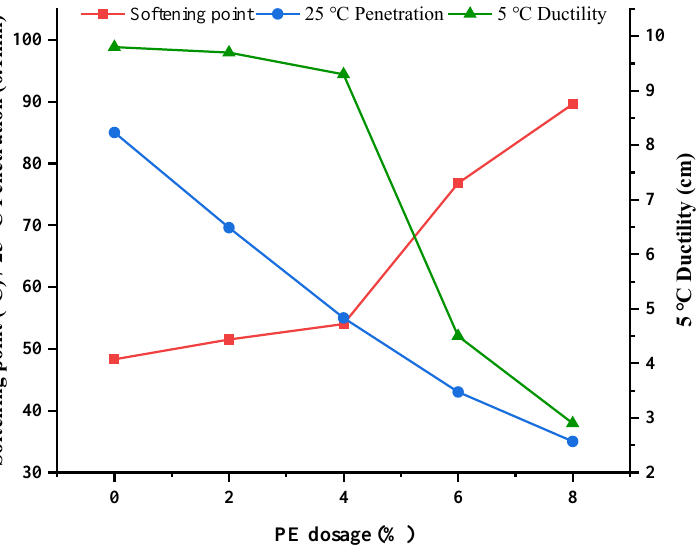
Figure 3. Influence curve of softening point, penetration, and ductility with different PE